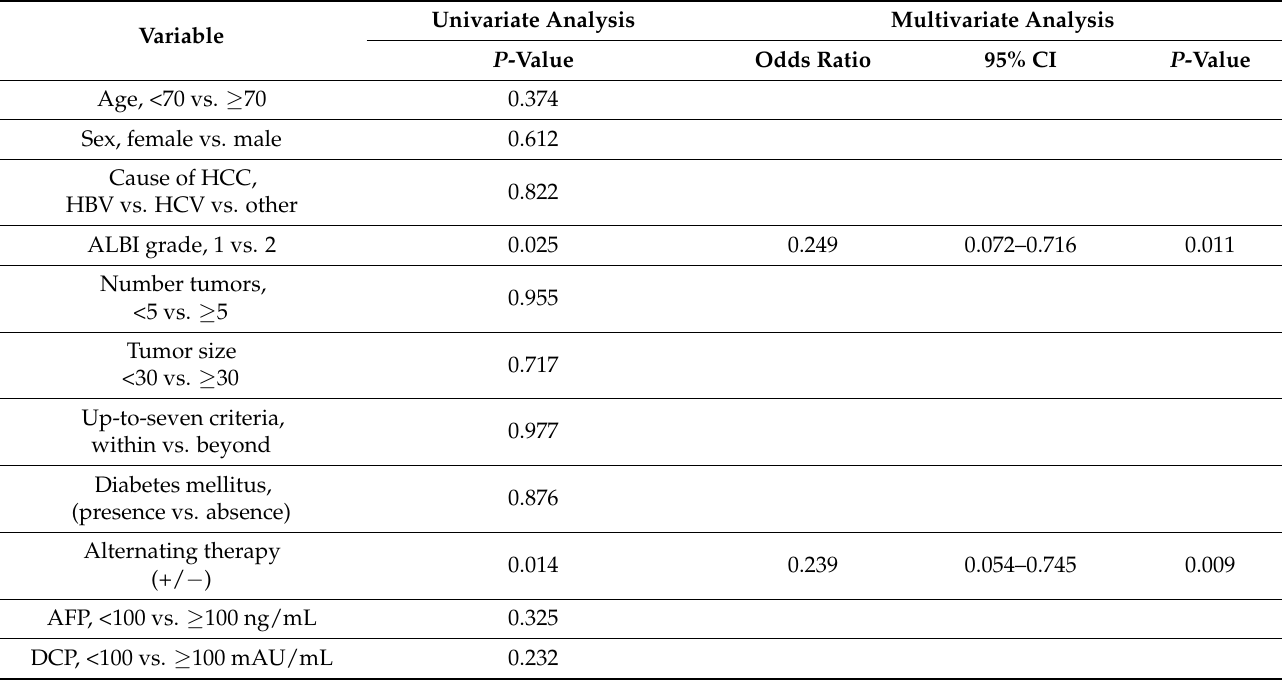
Table 3. Univariate and multivariate analyses of factors associated with OS after propensity score matching. Variable